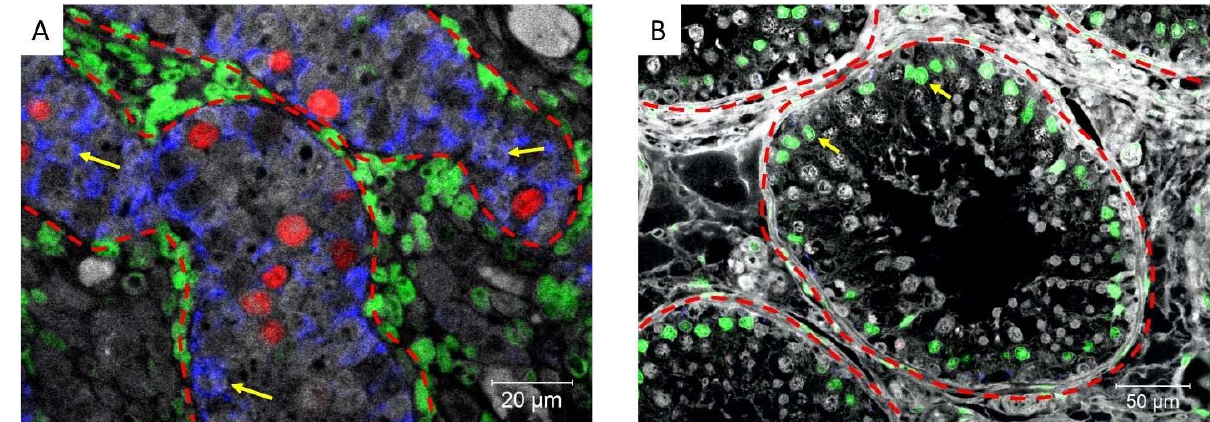
Figure 7. Cytokeratin (blue), Androgen receptor (green), and POU5F1 (red) expression in ( A ) an 18-week-old human fetal testis (where POU5F1 is normally expressed in fetal gonocytes) and ( B ) normal adult testis. Dashed lines represent the periphery of the tubules and yellow arrows: Sertoli cells.